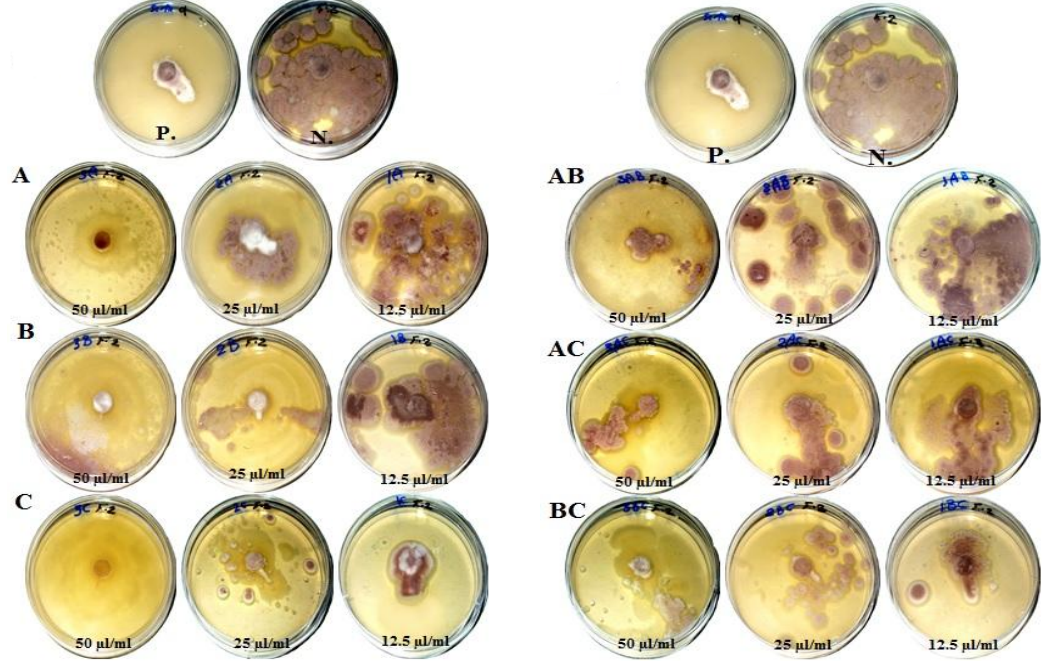
Figure 4. Visual observation A. terreus growth inhibition as affected by the EOs from ( A ) C. aurantium oil, ( B ) E. camaldulensis oil, and ( C ) C. sinensis oil and their combinations . ( P ) Positive control (Sertaconazol 3 g/L). ( N ) Negative control (DMSO 10%). ( AB ) C. aurantium oil + E. camaldulensis oil. ( AC ) C. aurantium oil + C. sinensis oil. ( BC ) E. camaldulensis oil + C. sinensis oil.